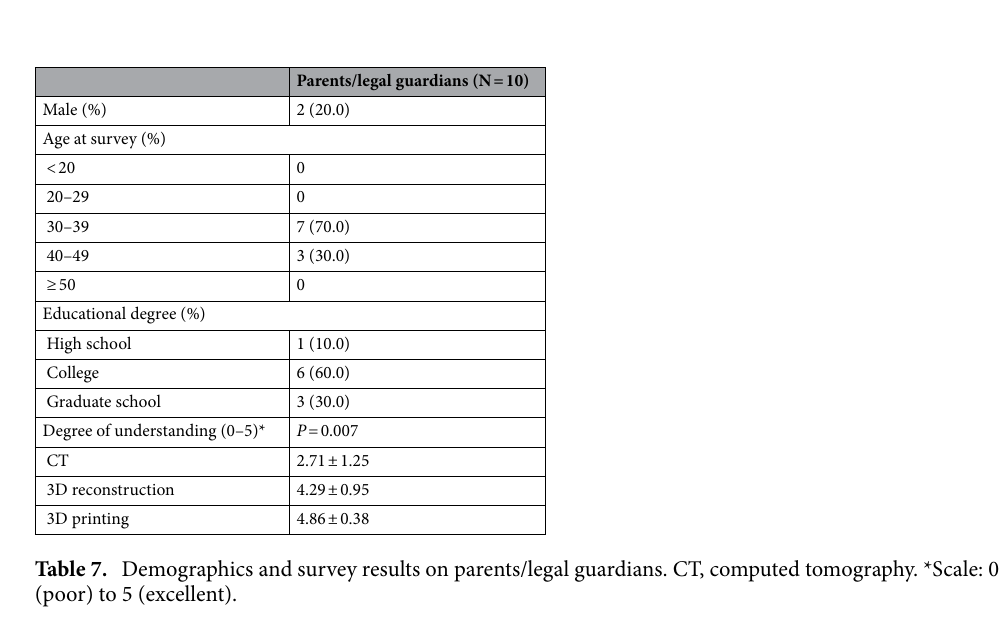
Table 6. Conclusive comprehension and satisfaction by certified pediatric surgeons. Scale: 0 (poor) to 5 (excellent). CT, computed tomography.